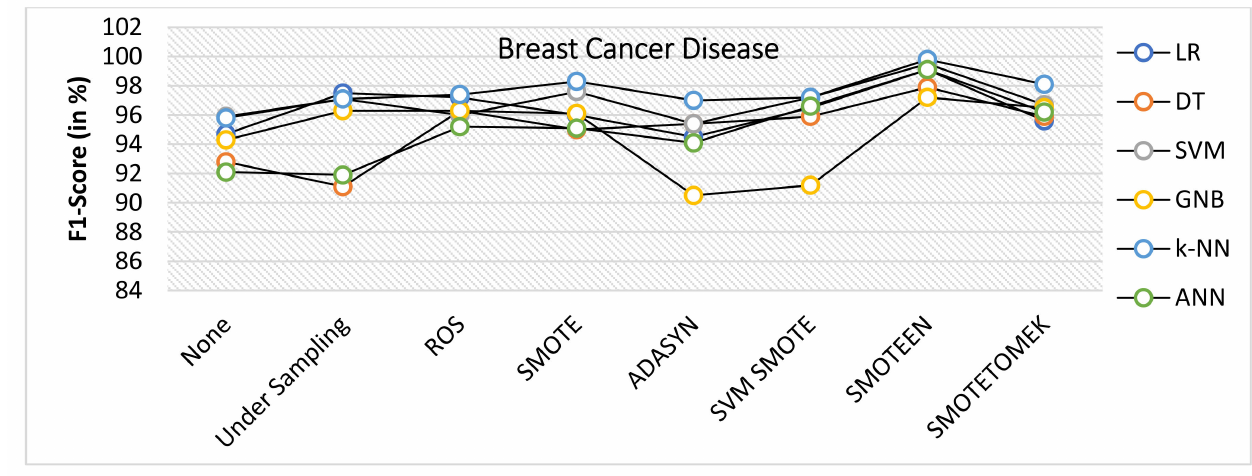
Figure 9. F1 Score for breast cancer disease dataset of balancing algorithms over six classifiers.